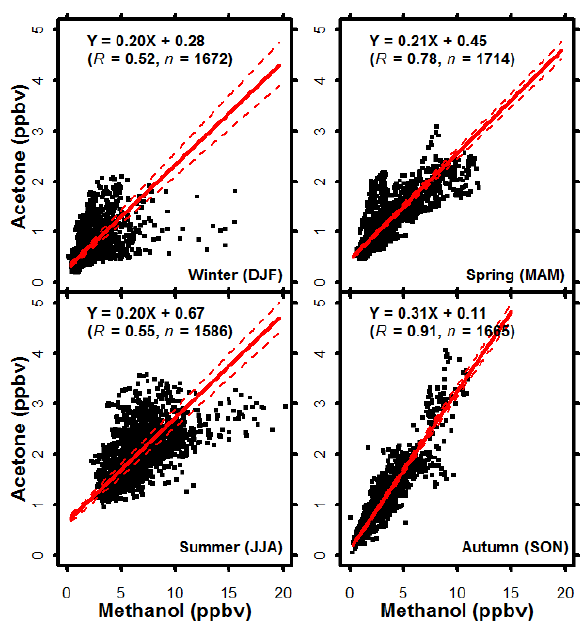
Figure 3. Seasonal linear correlation (major axis regression) between atmospheric acetone and 4 Fig. 3. Seasonal linear correlation (major axis regression) between methanol mixing ratios observed at the KCMP tall tower in 2010. Red dashed lines show the 5 atmospheric acetone and methanol mixing ratios observed at the 95% confidence interval for the best fit line (red solid line). Data points are 1 h means. 6 KCMP tall tower in 2010. Red dashed lines show the 95% confi- dence interval for the best fit line (red solid line). Data points are 1h